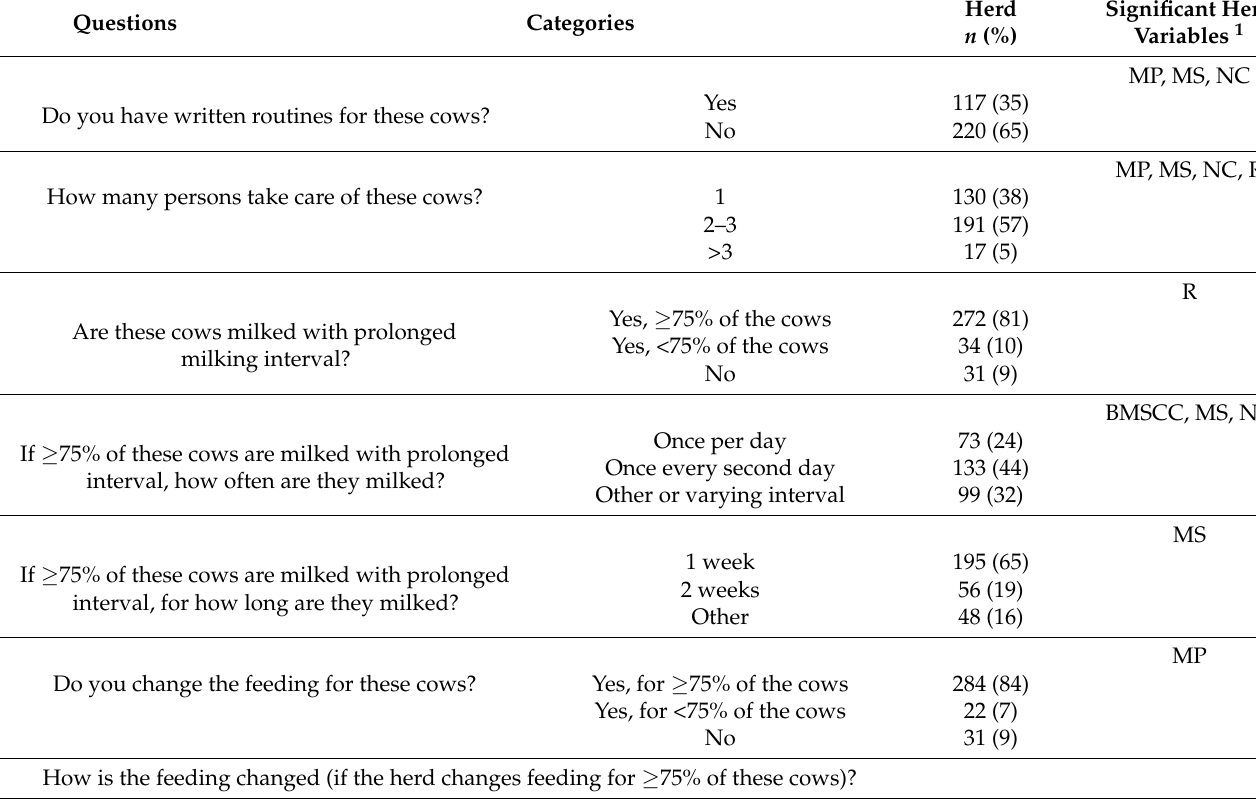
Table 1. Answers to questions about routines during drying-off of dairy cows given by farmers ( n = 340) responding to a web-based questionnaire. Associations between herd variables and answers were investigated by univariable regression models. If significant ( p ≤ 0.05) the herd variables are presented (see Supplementary Table S2 for